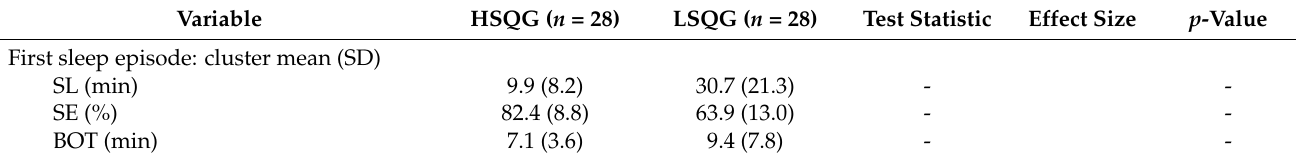
Table 2. Comparison of characteristics between two groups identified by cluster